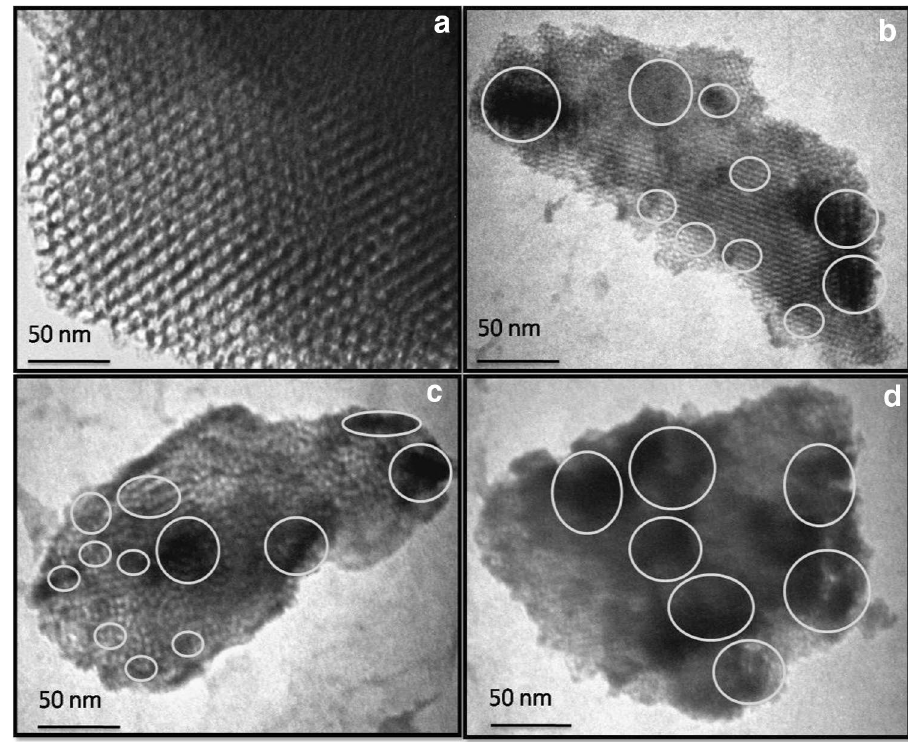
Fig. 7 TEM images of a KIT-6,